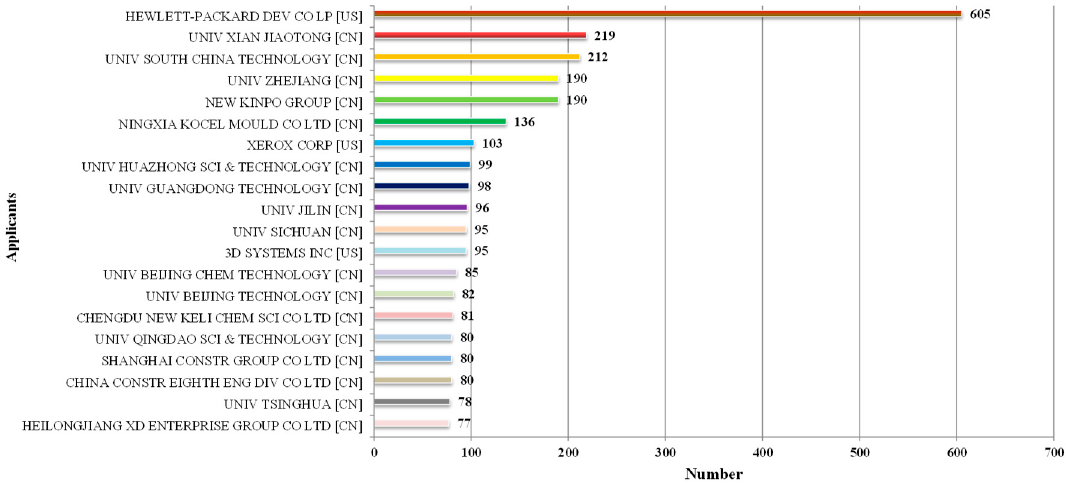
Figure 12. The major contributors to 3D printing patents.